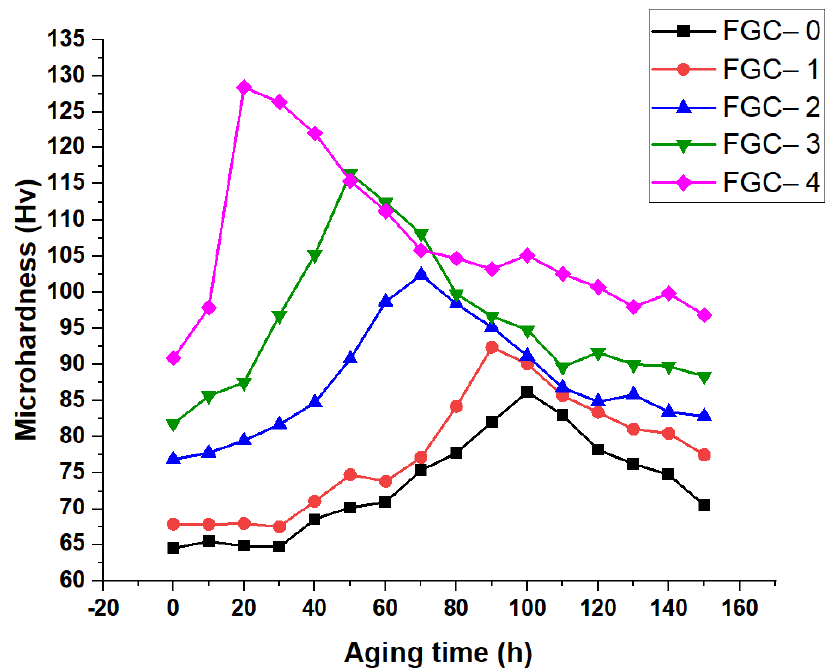
Figure 13. Effect of Y and silica fume on the aging-hardening behavior of FGCs aged at 180 °C.